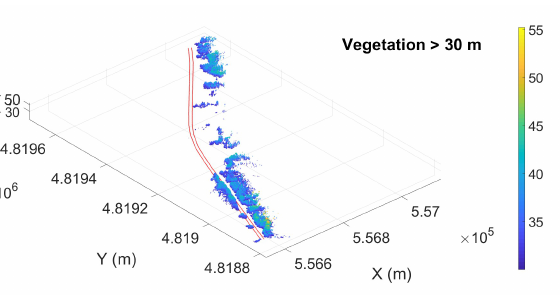
Figure 11. Vegetation points with greater height than 30 m.